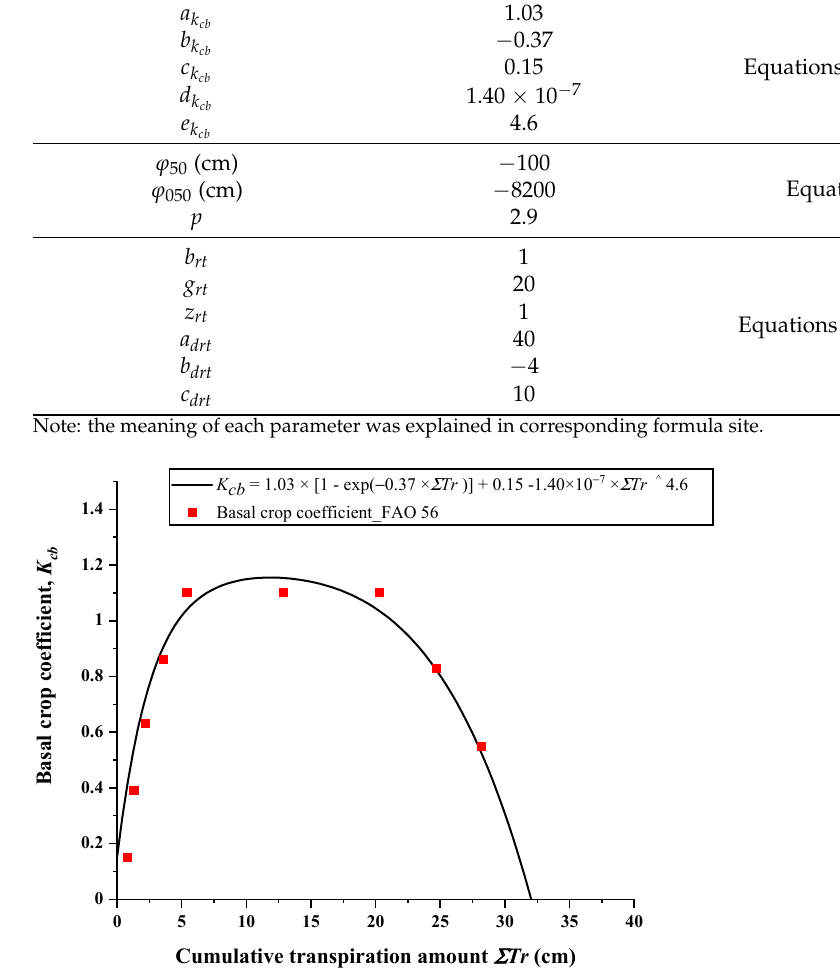
Figure 4. The basal crop coefficient ( K cb ) of potato as a function of cumulative transpiration ( ∑ Tr ) (parameter values of K cb function were obtained by fitting to values reported by Allen et al. (1996). (c). Irrigation and fertilizer Four drip irrigation tubes with a discharge rate of 1 L h − 1 per emitters were set in each plot, and the lateral and emitter distance spaced as 50 cm and 20 cm respectively as de- picted in Figure 3. Irrigation interval for S and R was set at two days, because the field capacity of the sandy soil in experiment site was only 0.09 cm 3 cm − 3 . Automated irrigation was triggered when the average readings of two tensiometers installed at the depth of 20 cm around plant was over than 45 cm, which was slightly higher than suction at field capacity and suitable for crop growth in sandy soil. To check the accuracy of volumetric water content (VWC) of the model simulated, four 10HS sensors (METER Inc., Pullman, Washington, WA, USA) were inserted into the soil profile at 4 observation points (x, z):